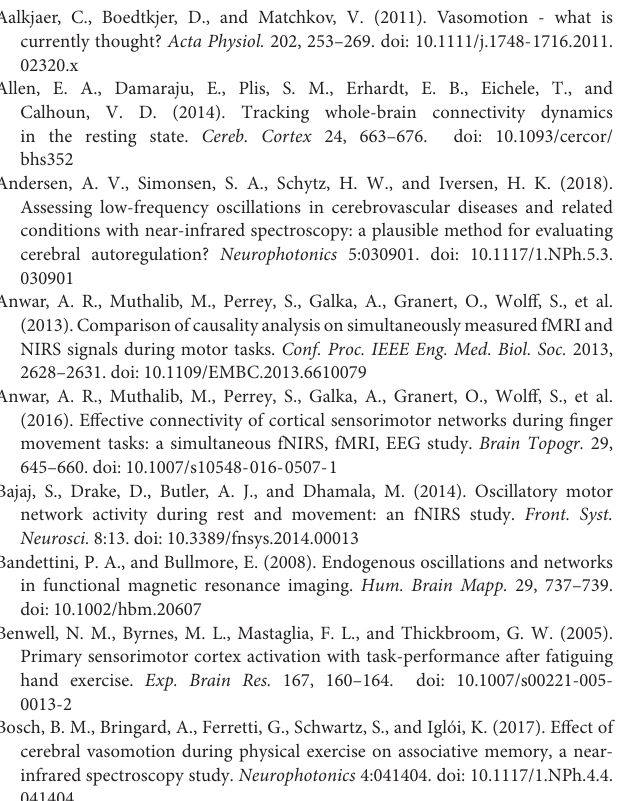
FIGURE S1 | Significant dPTE and DC in the endogenic frequency band for inactive and active subjects during the handgrip task for (cid:49) Hb. Directed PTE t -values for each ROI as a color-coded map for inactive subjects (A–C) and active subjects (D–F) . Hot (yellow-reds) and cold (light blue-dark blue) colors indicate information outflow and inflow, respectively. Arrows indicate statistically significant information flow between functional regions for inactive (G–I) and active subjects (J–L) . Black arrows ( p < 0.05); Red arrows ( p < 0.01). Eleven regions of interest (ROIs) were mapped: left and right frontopolar (lFP; rFP) (red), left and right pre-frontal cortex (lDLPFC; rDLPFC) (yellow), Broca’s area (green), left and right pre-motor cortex (lPMC; rPMC) (light blue), left and right primary motor and sensory cortical (lM1/S1; rM1/S1) areas (purple), and left and right sensory association cortex (lSAC; rSAC) (pink).